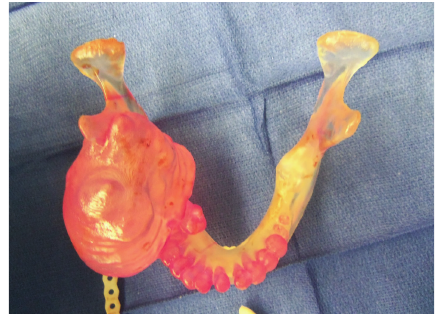
Figure4:Photomicrographshowingbrowntumorofhyperparathy- roidism.Multinucleatedgiantcellssurroundingaspiculeofboneare visible amidst a proliferative fibroblastic stroma (H&E, magnifica- tion × 400).